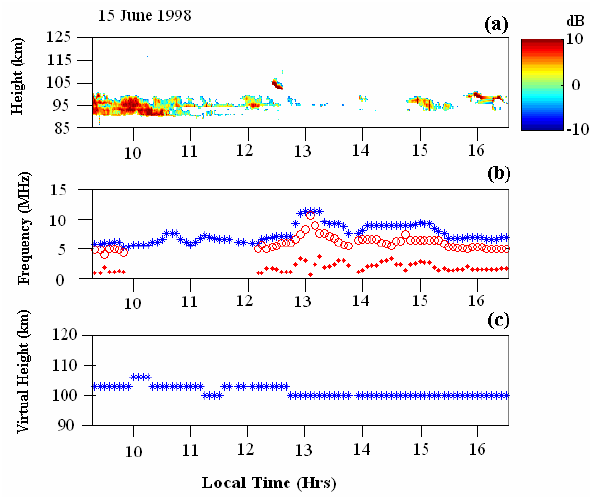
Fig. 1. ( a ) Height-time-intensity (SNR) map of the FAI, ( b ) time variations of the three parameters f t E s (star), f b E s (open circle), f t E s − f b Es (diamond), and ( c ) time variation of height of the E s layer observed during daytime on 15 June 1998.